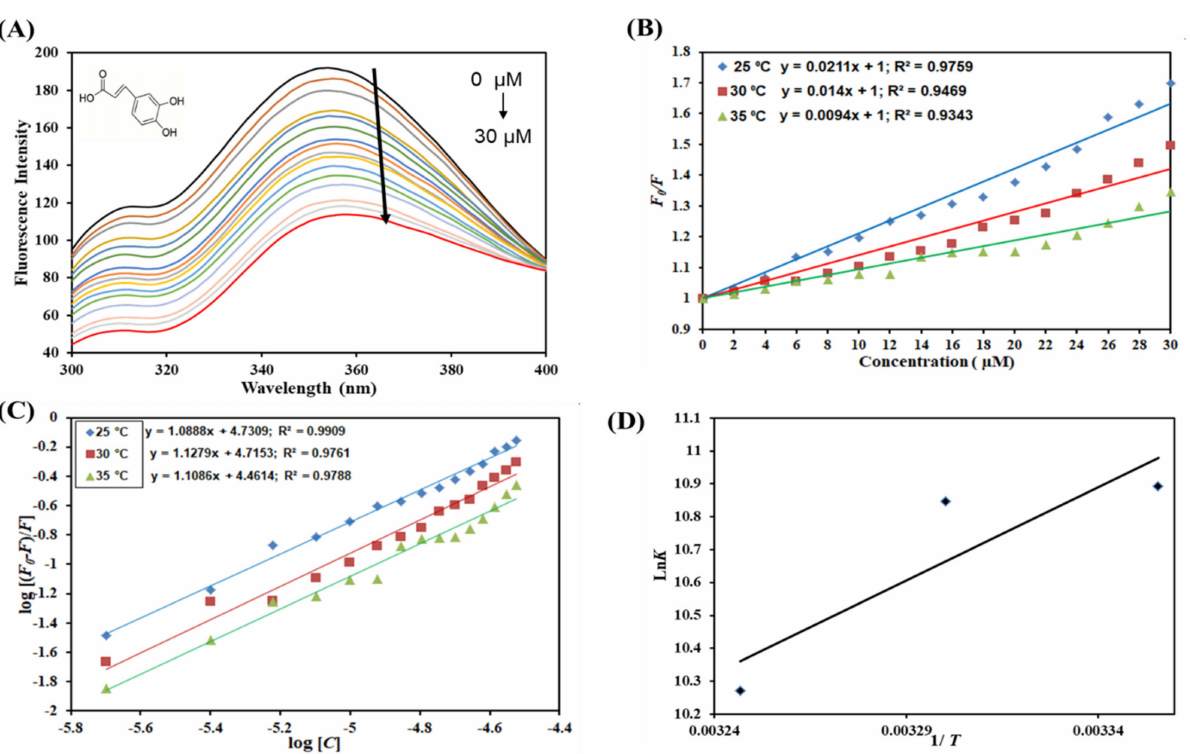
Figure 1. Binding between caffeic acid and α -amylase. ( A ) Quenching in fluorescence intensity of α -amylase (5 µ M) in the absence and presence of varying caffeic acid concentration (0–30 µ M) at 298 K, ( B ) Stern–Volmer plot at different temperatures, ( C ) modified Stern–Volmer plot at different temperatures, and ( D ) van’t Hoff thermodynamics plot at three different